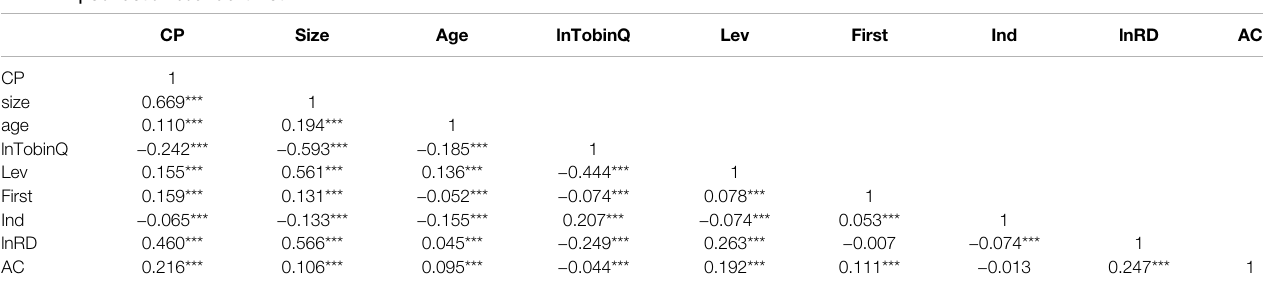
TABLE 4 | Correlation coef fi cient